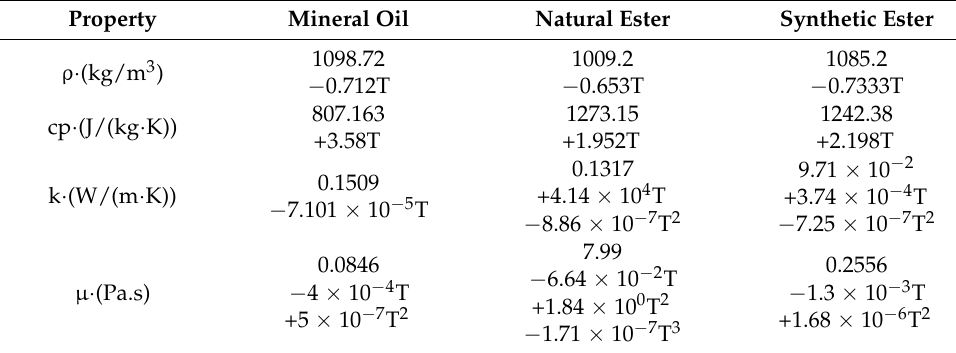
Table 5. Properties of the fluids [30]. The complete study is reported in [30]. Reprint with permission [30], Copyright 2019,